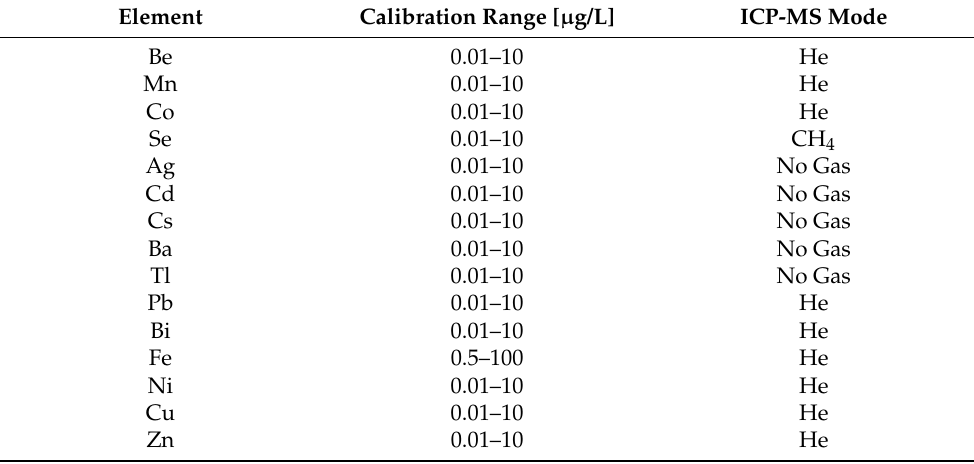
Table 6. Calibration range and ICP-MS modes for analyzed elements performed on NexION 2000C (Perkin